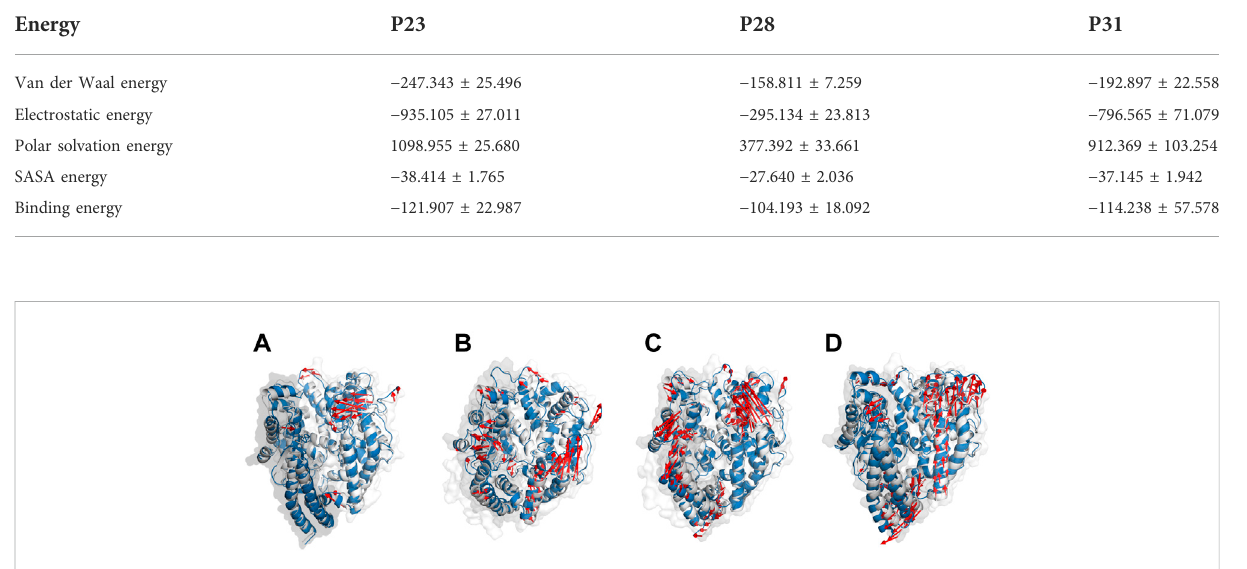
FIGURE 6 The main motion of PD (A) , P23-PD (B) , P28-PD (C) and P31-PD (D) during the initial (white cartoon) and the last (blue cartoon) frames of the simulations. The subdomains I and II are represented as grey and white transparent cartoons,